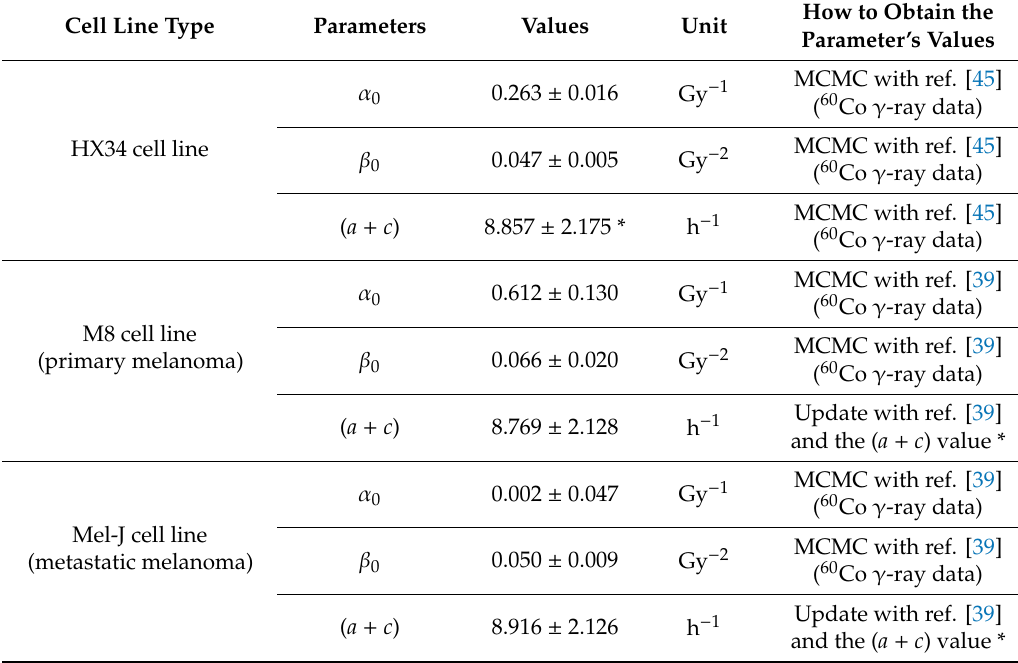
Table 1. Model parameters determined by Markov chain Monte Carlo (MCMC) simulation of human melanoma.